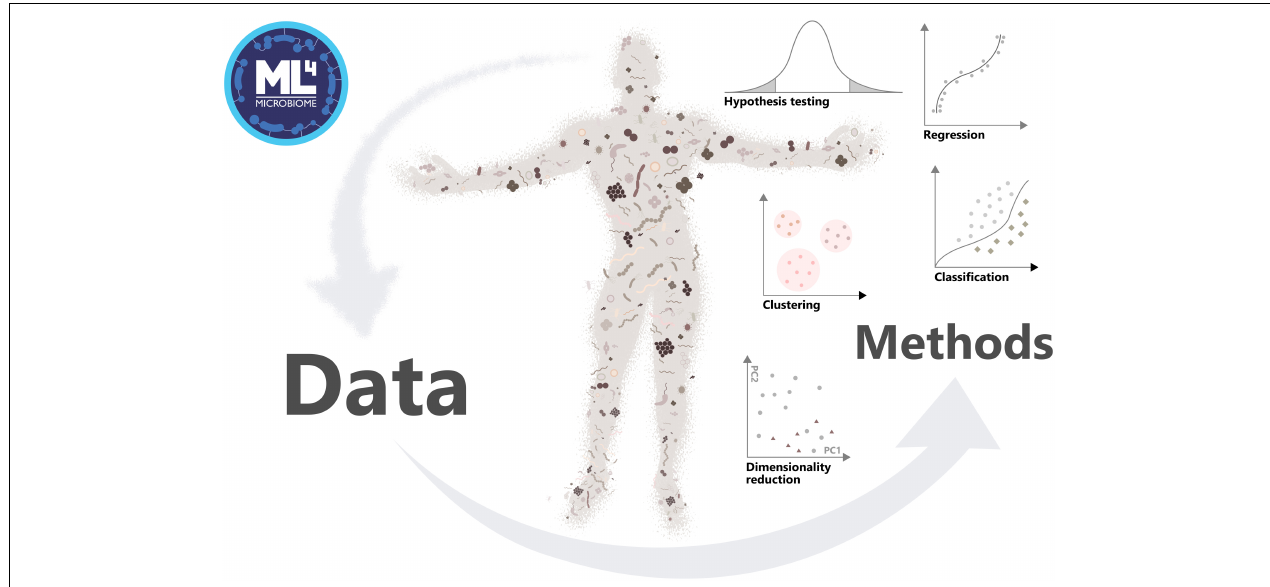
FIGURE 1 | Approach of the Action ML4Microbiome to the implementation of machine learning methods in microbiome research, driving change of the field in personalized medicine.